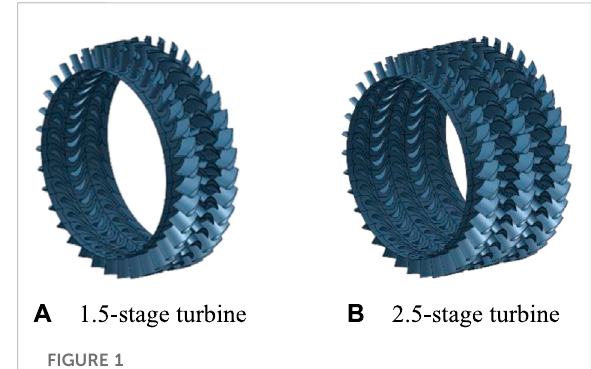
FIGURE 1 Geometry of